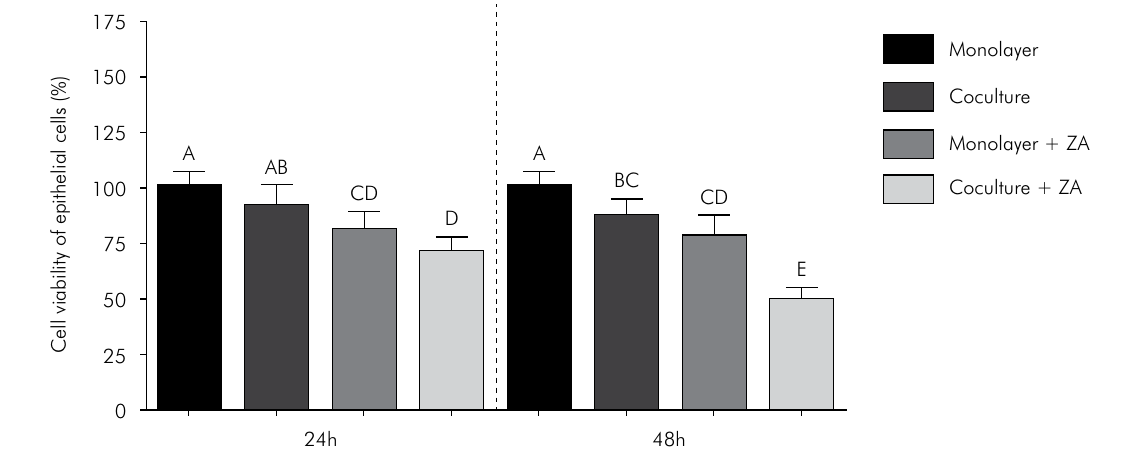
Figure 2. Viability of the epithelial cells that were exposed to ZA in the monolayer and co-culture models. The columns represent the mean values ± standard deviation. The different letter labels indicate statistically significant differences for each period (Tukey’s test, p < 0.05).